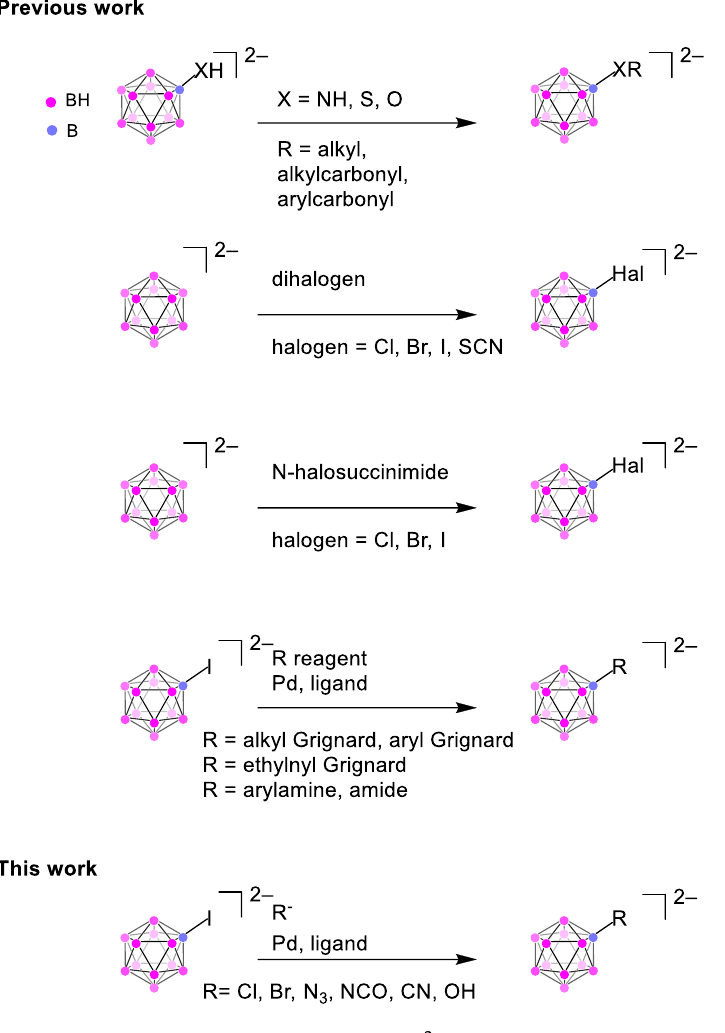
Scheme 1. Substitution reactions of [B 12 H 12 ] 2−